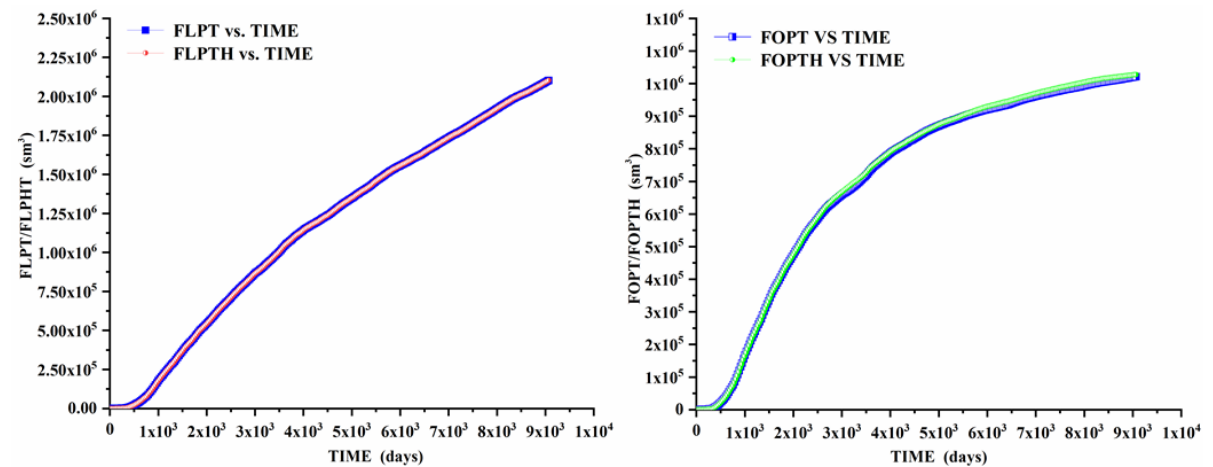
Figure 16. ( a ) Accumulated oil production fitting; ( b ) Fitting of cumulative fluid production across the region.